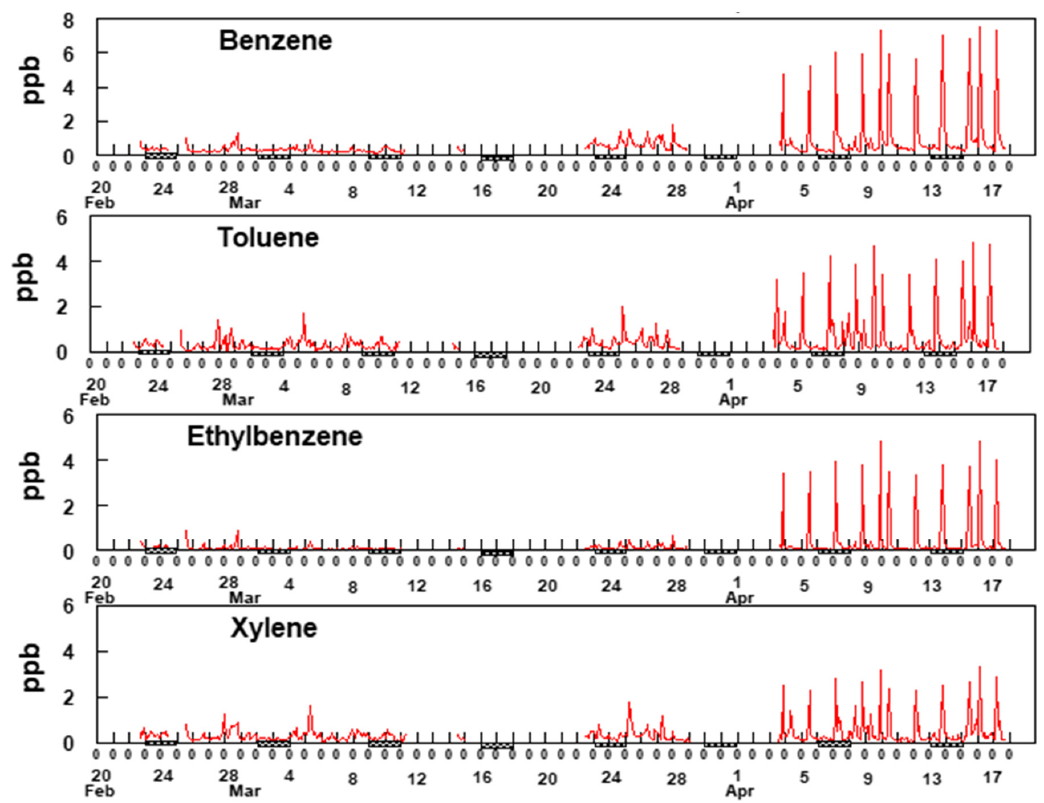
Figure 6. Two-hour average data for BTEX. Xylene represents a sum of o-,m- and p- xylenes. The hash marks under the x -axis indicates weekends.